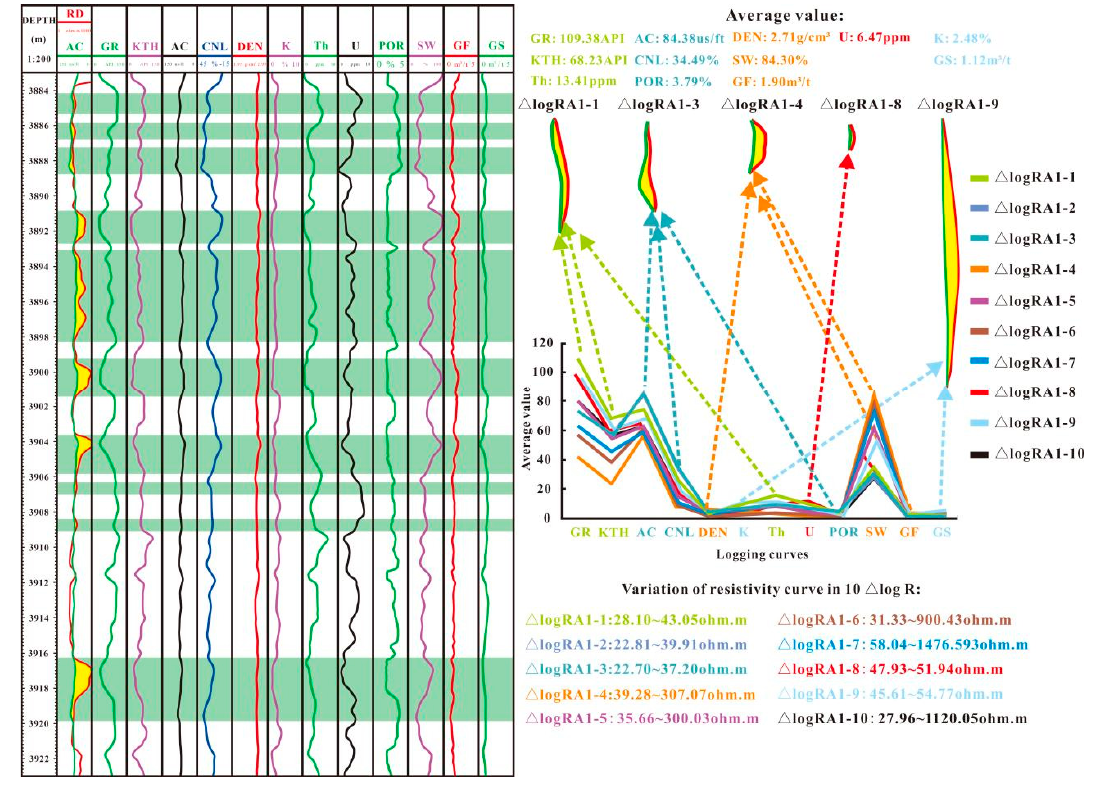
Figure 5. ∆ Log R of well A1 and the average of the corresponding reservoir parameters. Table 9. Actual logging data corresponding to ∆ logR1-1, ∆ logR1-3, and ∆ logR1-4 in A1 well. Table 10. Actual logging data corresponding to ∆ logR1-8 and ∆ logR1-9 in A1